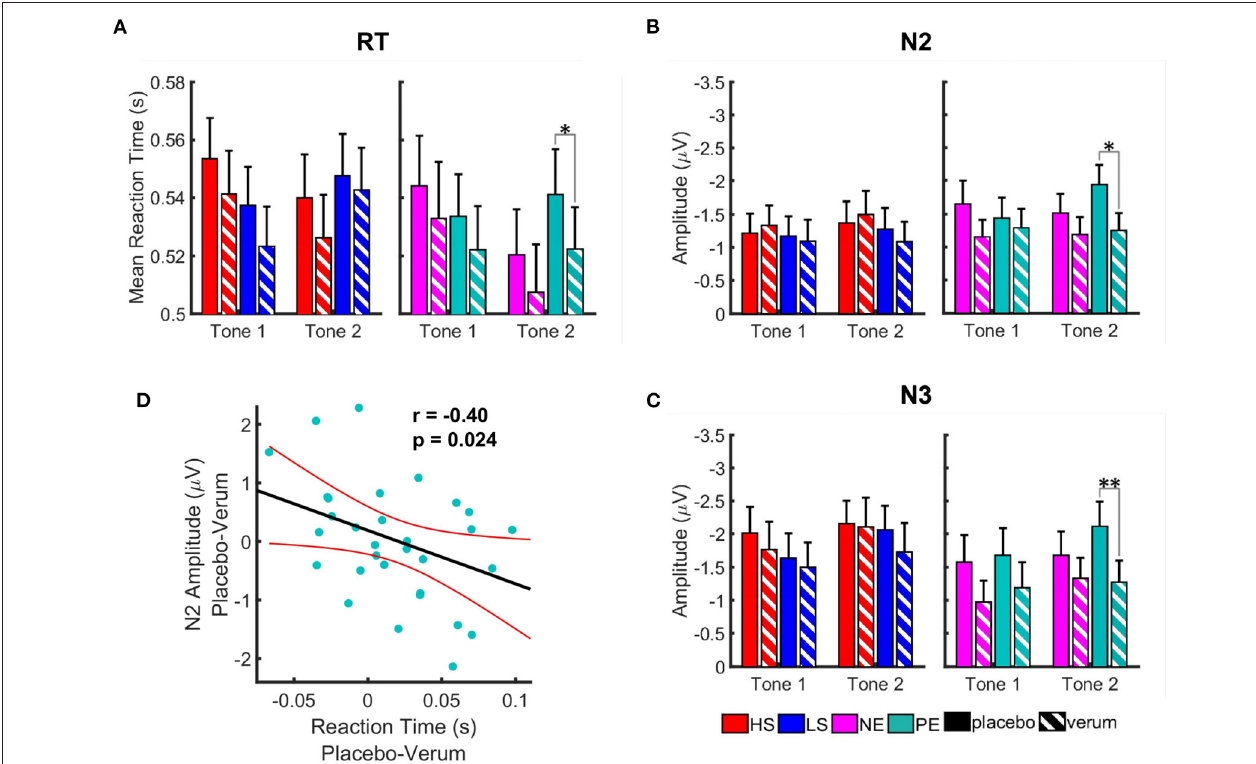
FIGURE 6 | Effect of Nx4 on reaction time (A) and amplitudes of the ERP components, N2 (B) , and N3 (C) . Data for high salient (HS) condition are shown in red, low salient (LS) in blue, negative valence (NE) in magenta, and positive valence (PE) in turquoise. Solid bars represent data for placebo condition, striped ones for Nx4. Data are given as mean and standard error. Stars correspond to the significance levels (** p < 0.01, and * p < 0.05) after Bonferroni correction. We observed an overall reduction of the RT and amplitudes of ERPs after Nx4 intake, that was more prominent for positive and negative emotional distractors (D) Correlation of the Nx4 effect on the reaction time and amplitude of N2 ERP component for positive emotional distractor at tone 2. Nx4 effect on the reaction time ( x -axis) and amplitude of N2 ERP component ( y -axis) was estimated by subtraction of the values under the Nx4 condition from the ones under placebo for each participant (i.e., Nx4 effect = placebo–Nx4). Each dot represents data for one participant; red lines indicate confidence interval of the linear model